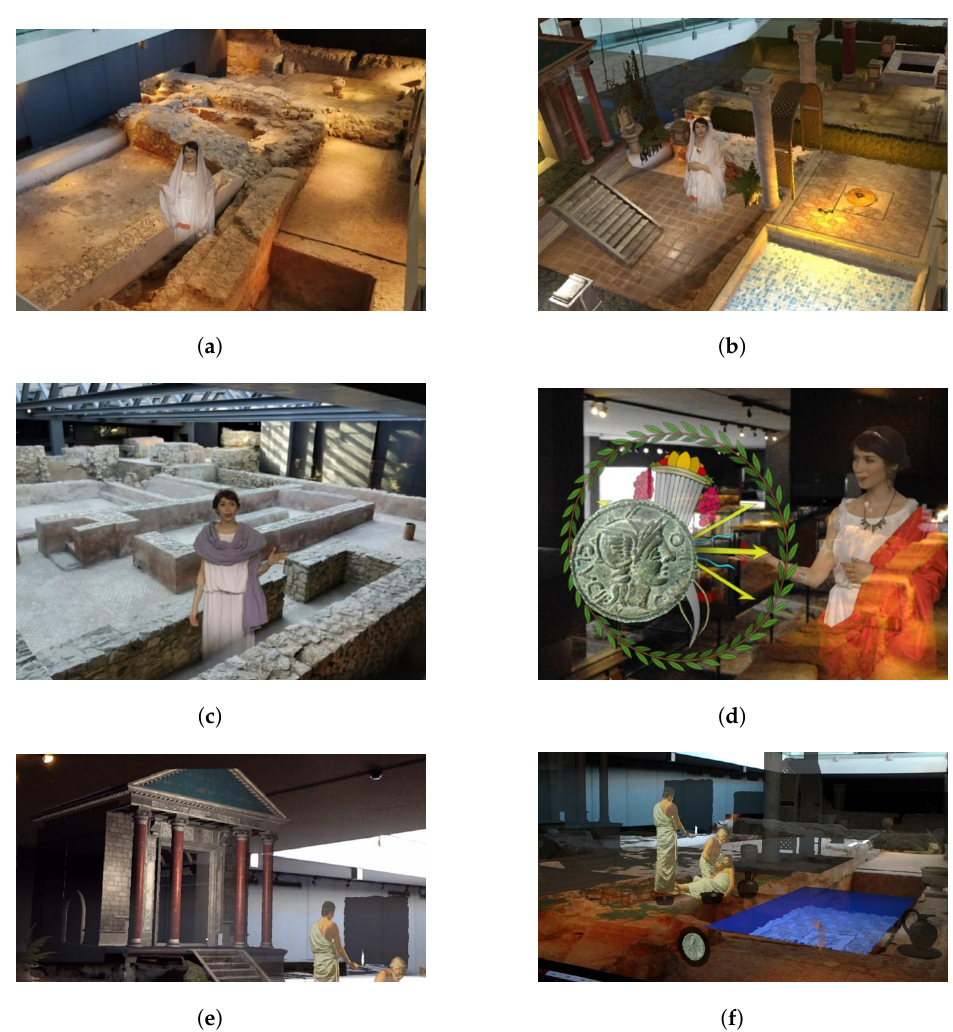
Figure 11. Alpha version of the AR-based interface developed: ( a – f ) images show different moments of the Almoina museum visit using the proposed AR